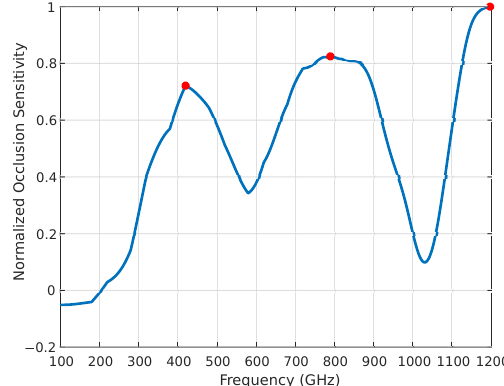
Figure 11. OSF function with marked peaks.